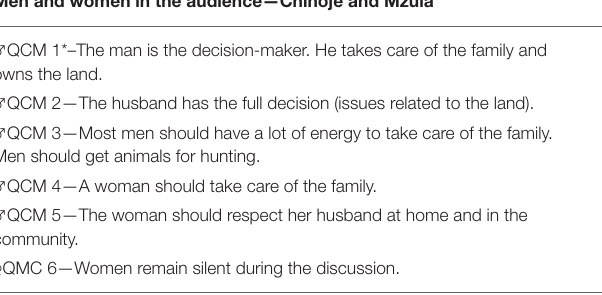
TABLE 2 | Perceptions on femininities and